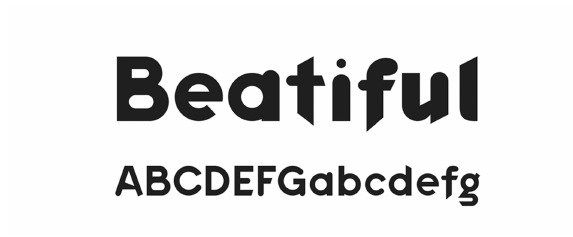
Figure 9. The typeface ‘Keedy Sans’ by Jeffrey Keedy